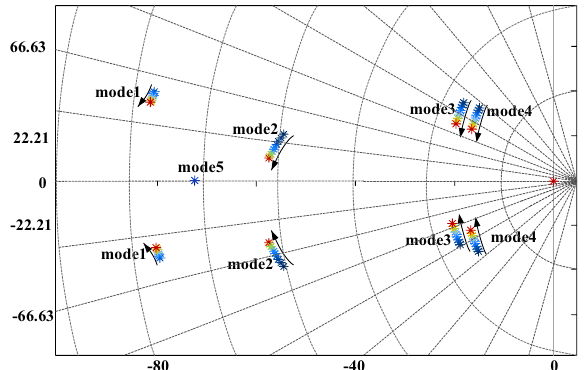
Figure 10. Comparison of eigenvalues after damping ratio optimization.